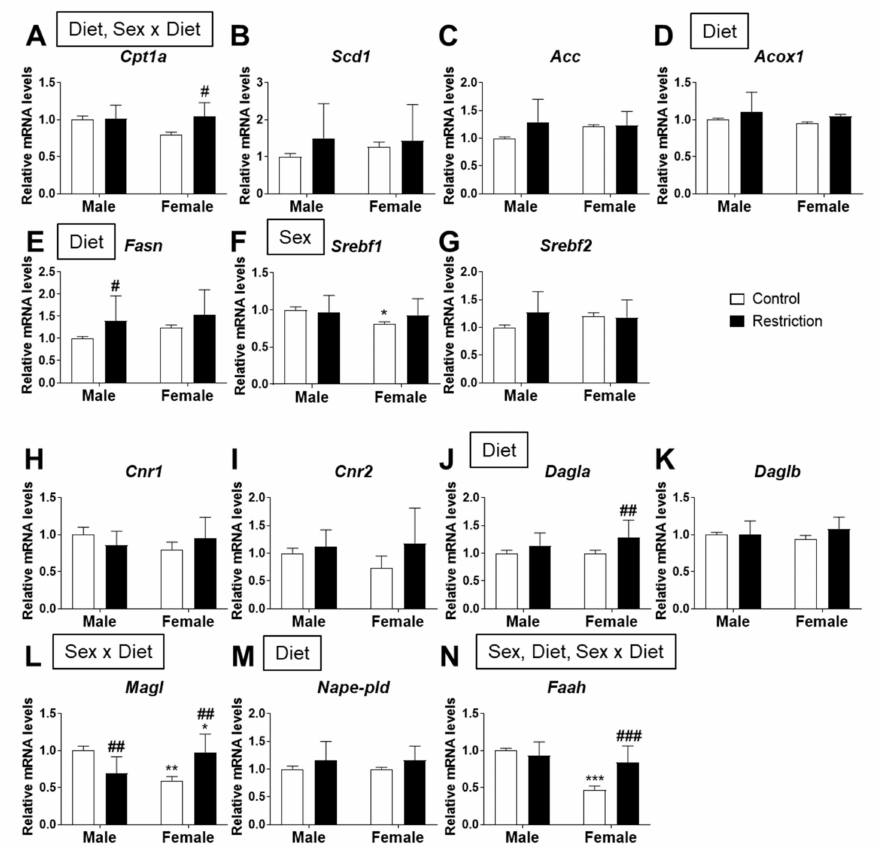
Figure 5. Effect of maternal caloric restriction on mRNA expression of principal genes of